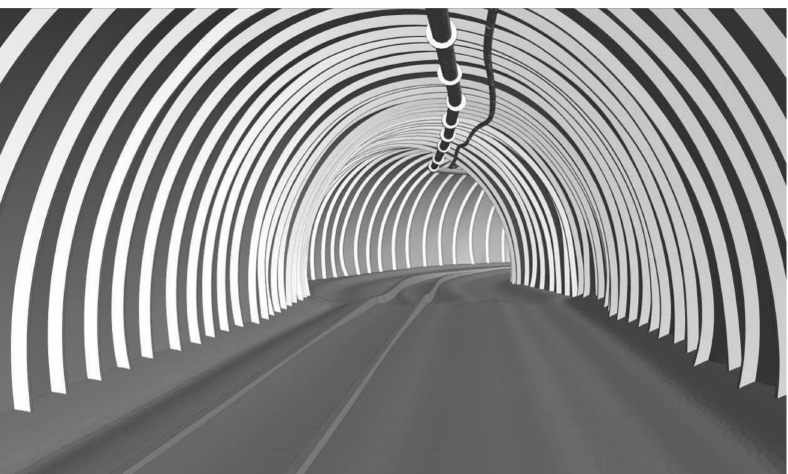
Figure 4. Geometry of the numerical mode—an ‘inside’ view of a straight section of a mine gallery before a